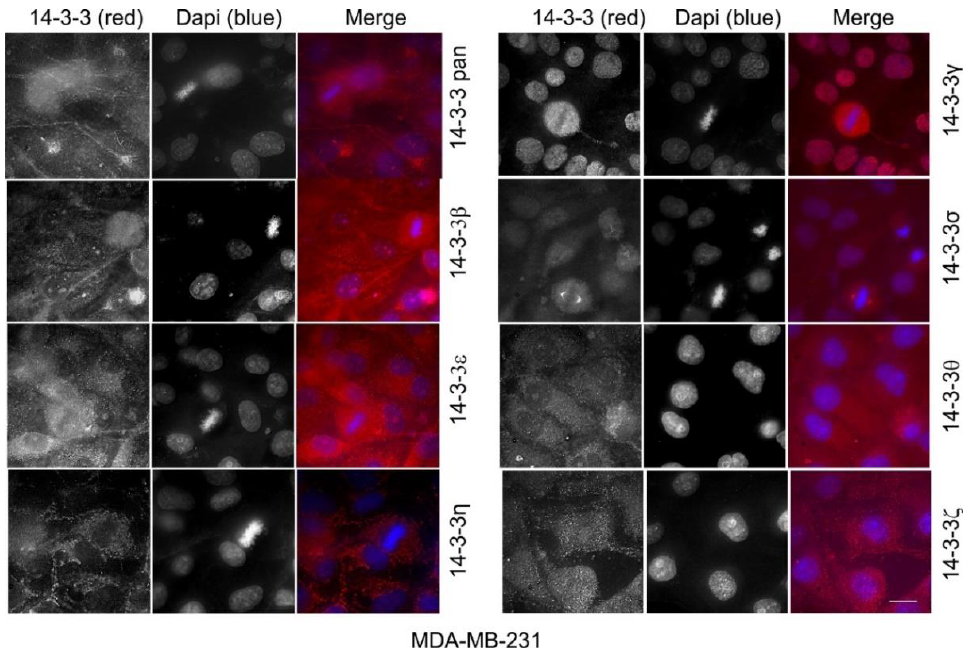
Figure 12. Subcellular localization of the total 14-3-3 protein and the seven 14-3-3 isoforms in MDA-MB-231 cells by immunofluorescence. The total 14-3-3 proteins were determined by a pan14-3-3 antibody. Each 14-3-3 isoform was determined by antibodies to each specific isoform. Immunoblotting, immunofluorescence, and subcellular fractionation were performed as described in Materials and Methods. 14-3-3 proteins were revealed by TRITC (red) and the chromatin was stained by DAPI (blue). Scale bar = 10 µm.